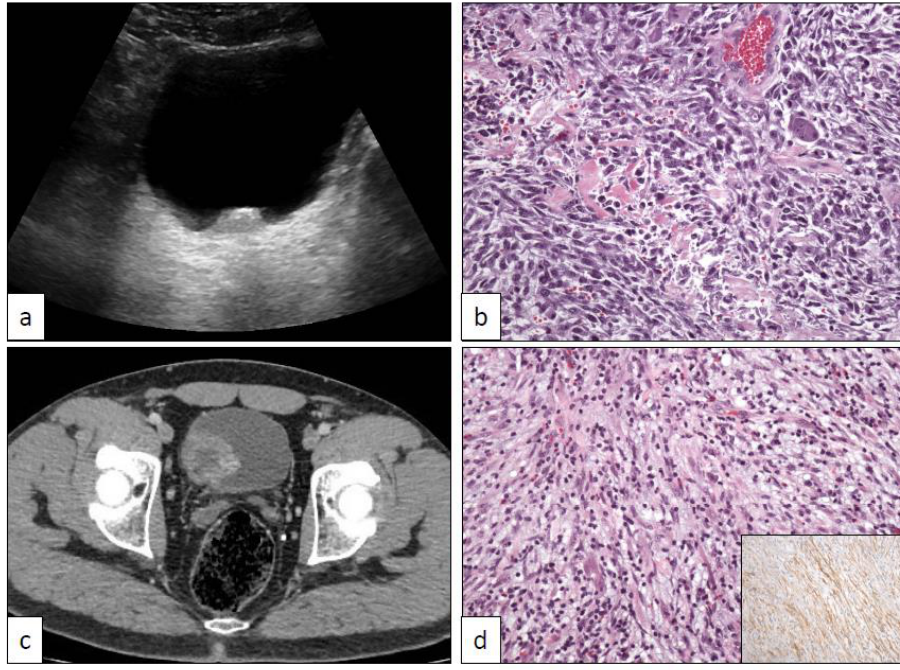
Figure 6. Post-operative spindle cell tumor of the bladder showing typical sonographic ( a ) and histological ( b ) features. Inflammatory myofibroblastic tumor of the bladder displaying characteristic CT scan ( c ) and histological ( d ) findings.